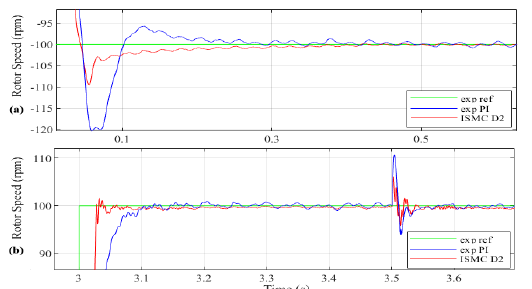
Figure 8. Experimental tests for performance comparison between the proposed ISMC (D2 design) and the PI regulators by using 100 rpm reference